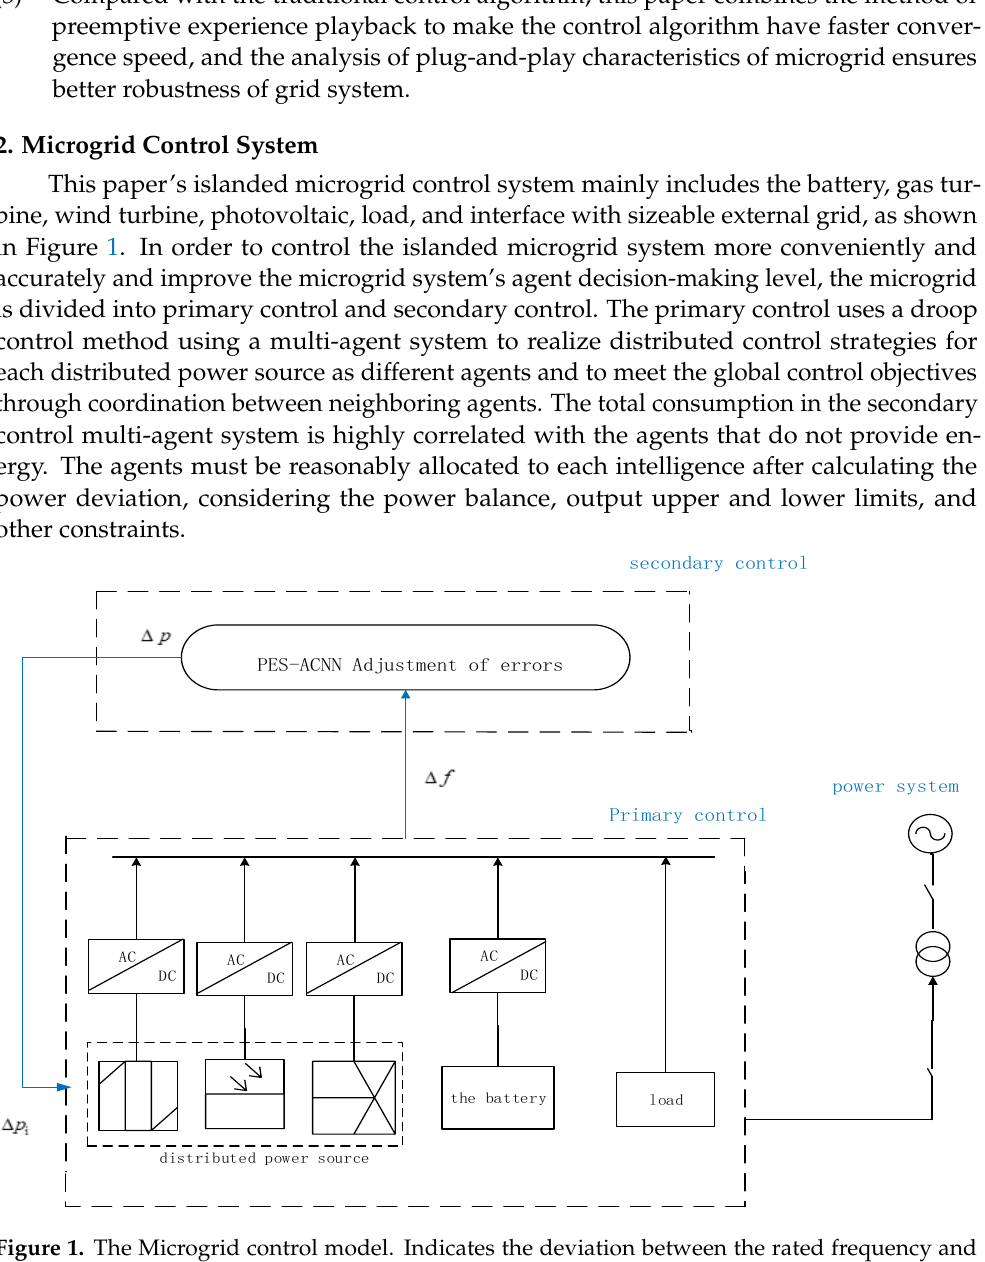
Figure 1. The Microgrid control model. Indicates the deviation between the rated frequency and power of the system.